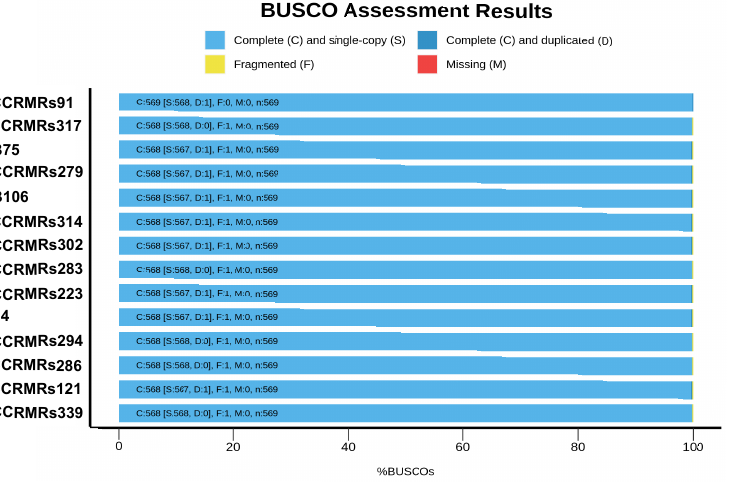
Figure 1. Genome completeness for Northern and Northeastern sequenced RSSC